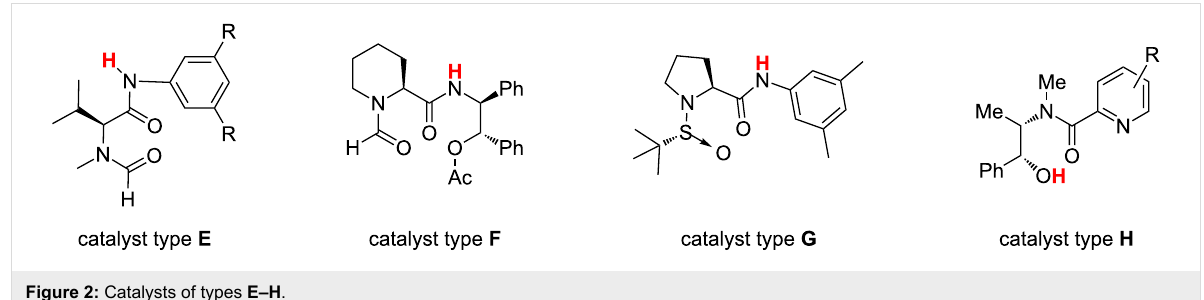
Figure 2: Catalysts of types E–H .